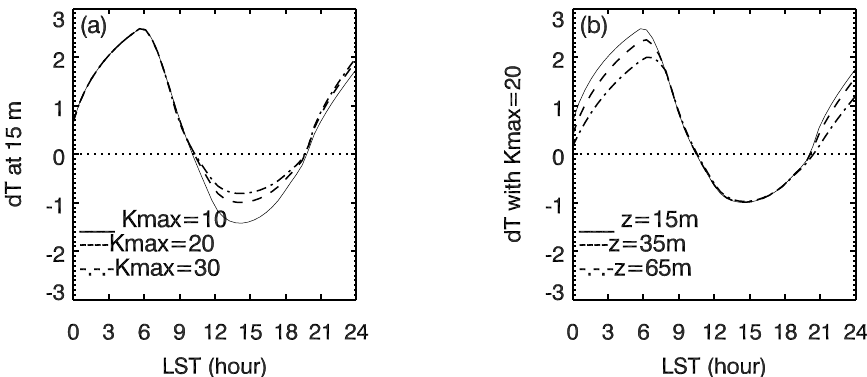
Figure 4. Diurnal variation of temperature response to ∆ J at 15 m with different K t , max ( a ) and at different height with K t , max = 20 ( b